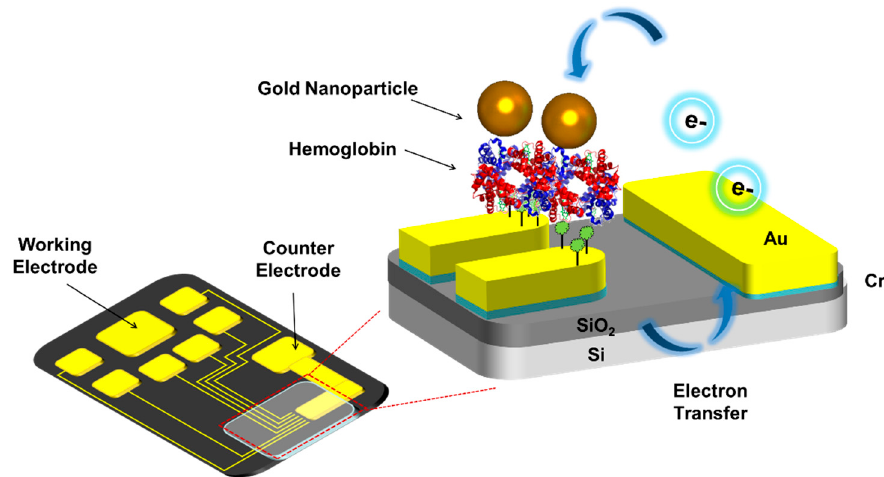
Figure 1. Schematic diagram of fabricated hemoglobin/gold nanoparticle heterolayer immobilized on the micro-gap for H 2 O 2 detection.